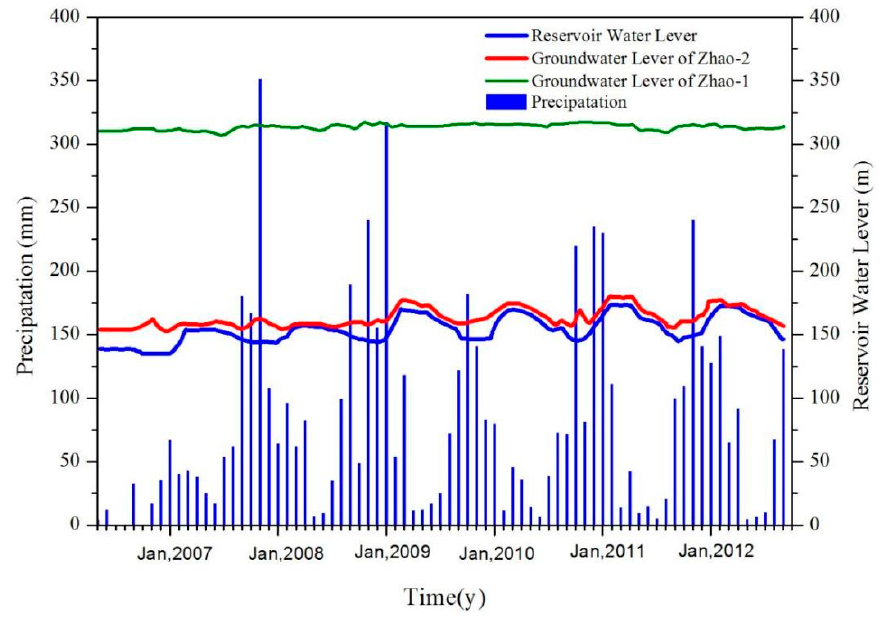
Figure 17. Relationships between precipitation, reservoir water levels, and groundwater levels of the Zhao-1 and Zhao-2 borehole sites.